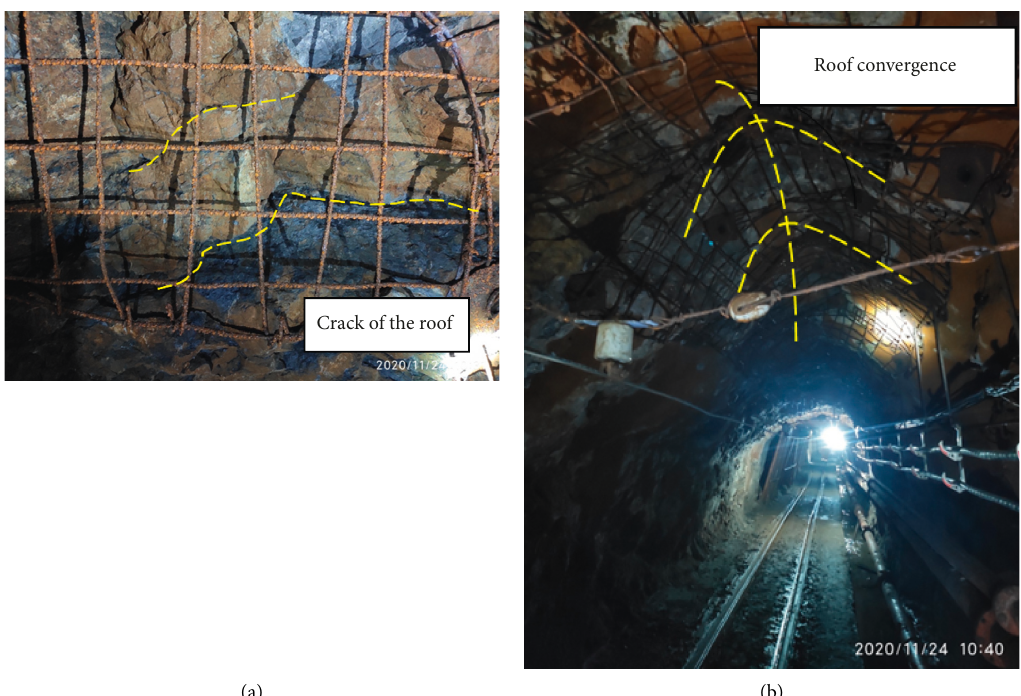
Figure 4: Roof deformation and failure of 760m haulage roadway: (a) roof crack and (b) roof convergence.